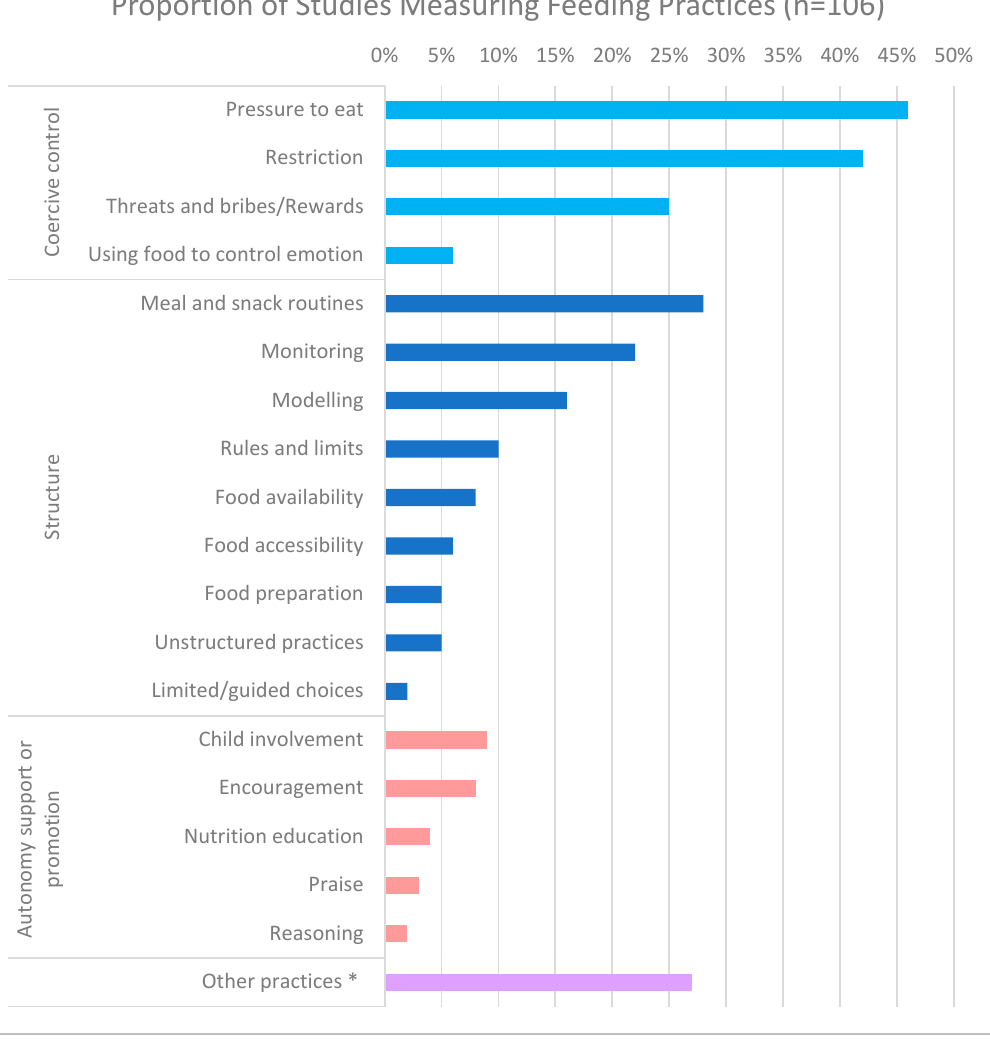
Figure 2. Proportion of studies measuring feeding practices ( n = 106). * Representing a variety of disparate practices which do not fit strictly within the Vaughn framework. Table 1. Summary of studies examining feeding practices and/or styles amongst families experienc- ing disadvantage, including food insecurity (N =